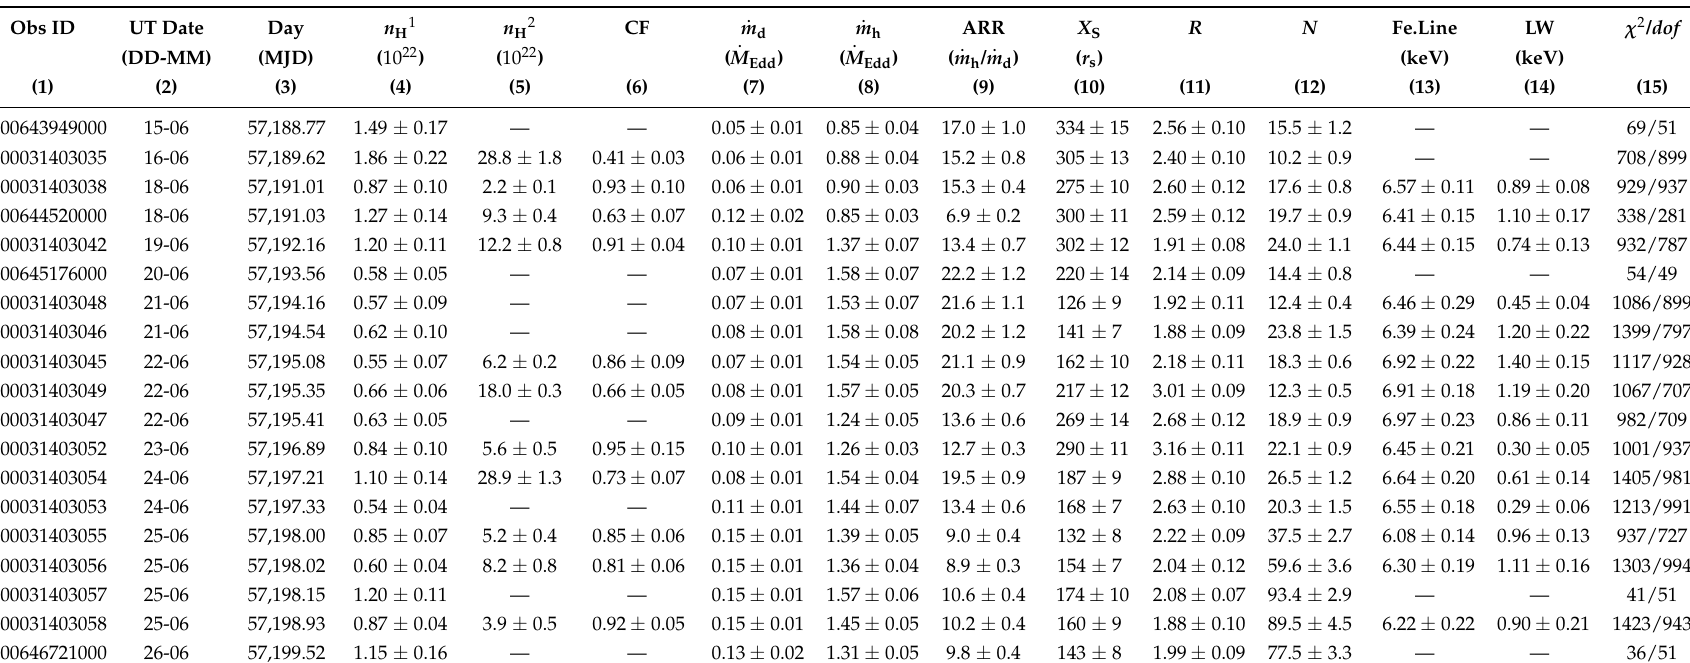
Table 2. TCAF Model Fitted Spectral Analysis